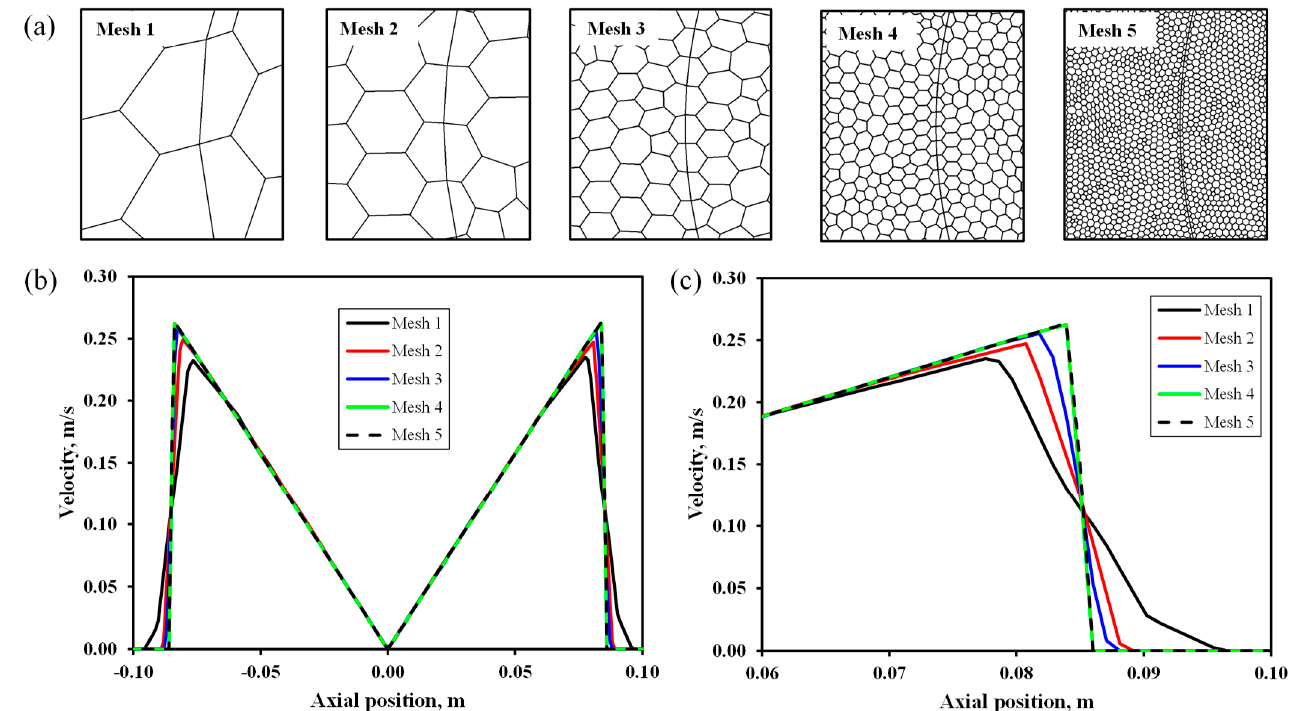
Figure 2. Illustration of meshing quality examples for grid sensitivity analysis showing ( a ) the grids and (both b and c ) the sensitivity.